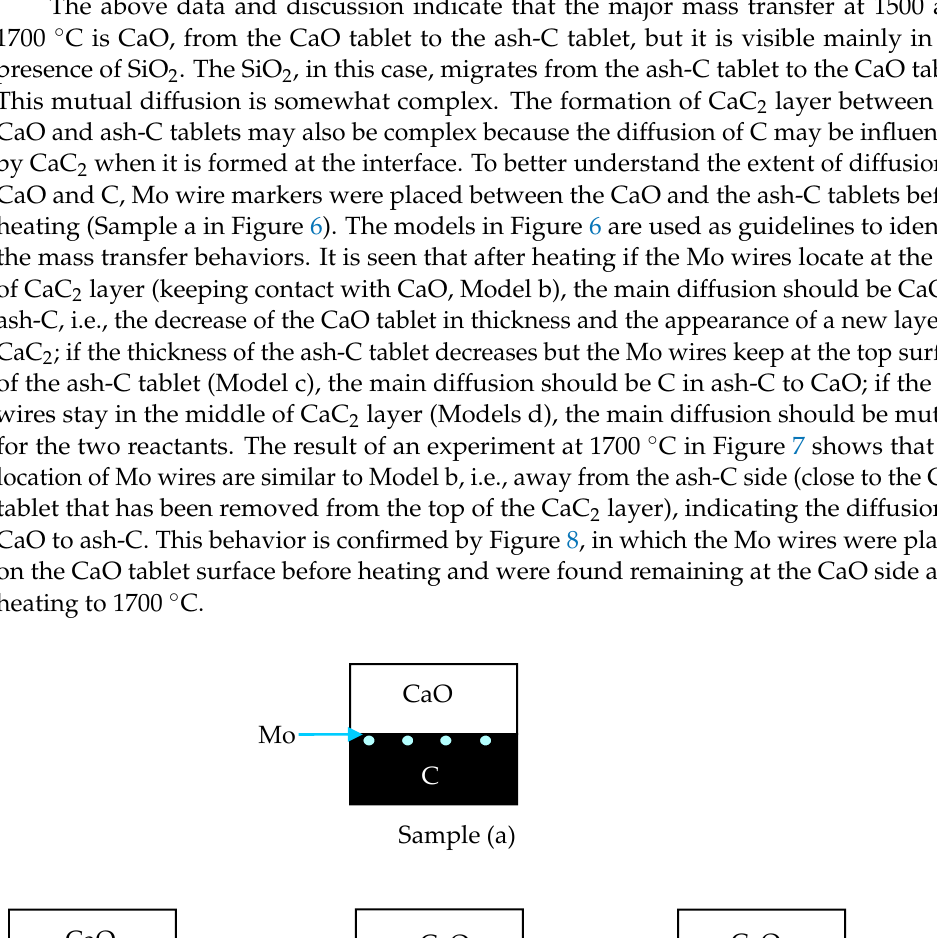
Figure 5. The analyses of CaC 2 layer: XRD ( left ) and SEM+EDX ( right ).